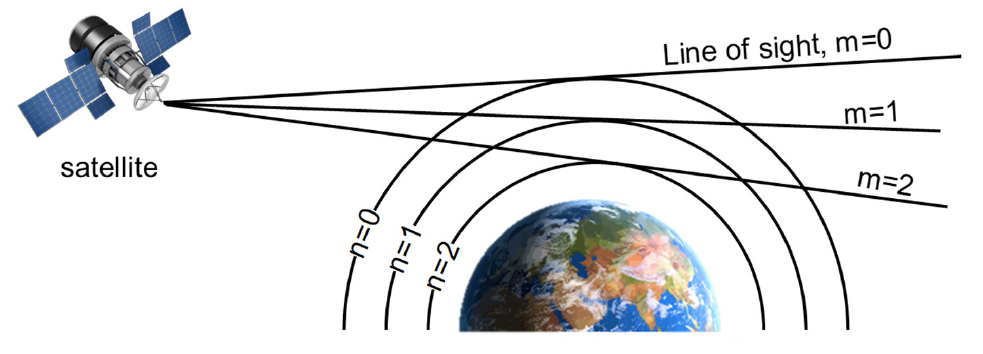
Figure 9. Limb viewing geometry of satellite.